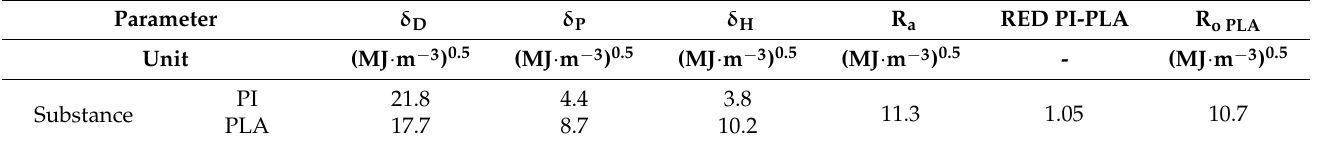
Table 2. Calculated Hansen solubility parameters of polyimide (PI) and polylactide (PLA) by means of HSPiP software. Parameter